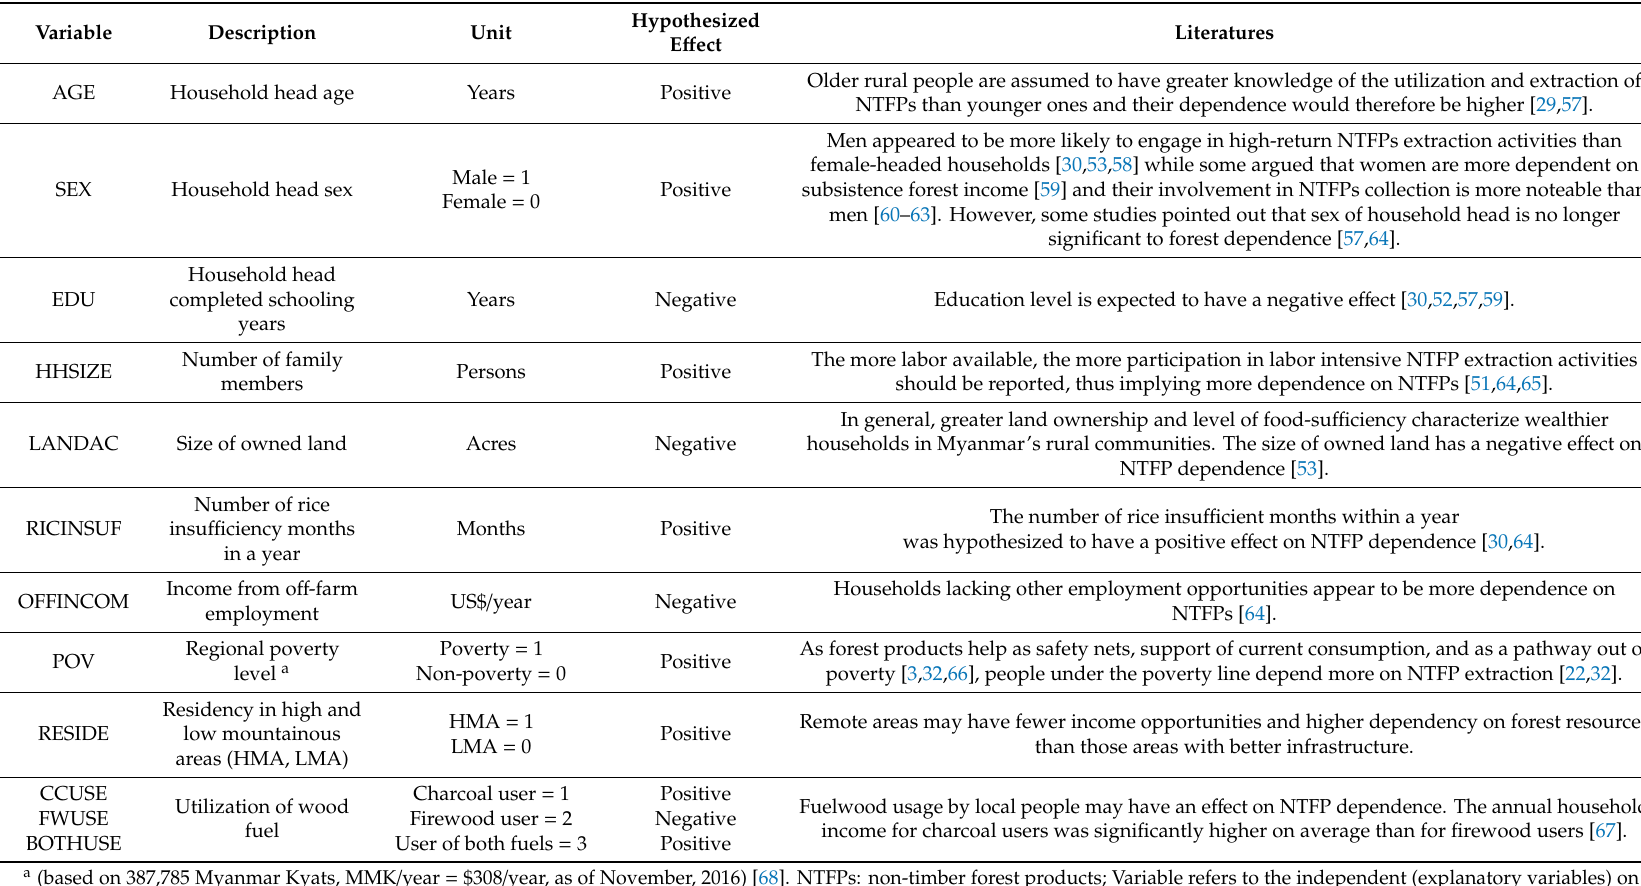
Table 1. Description of the explanatory